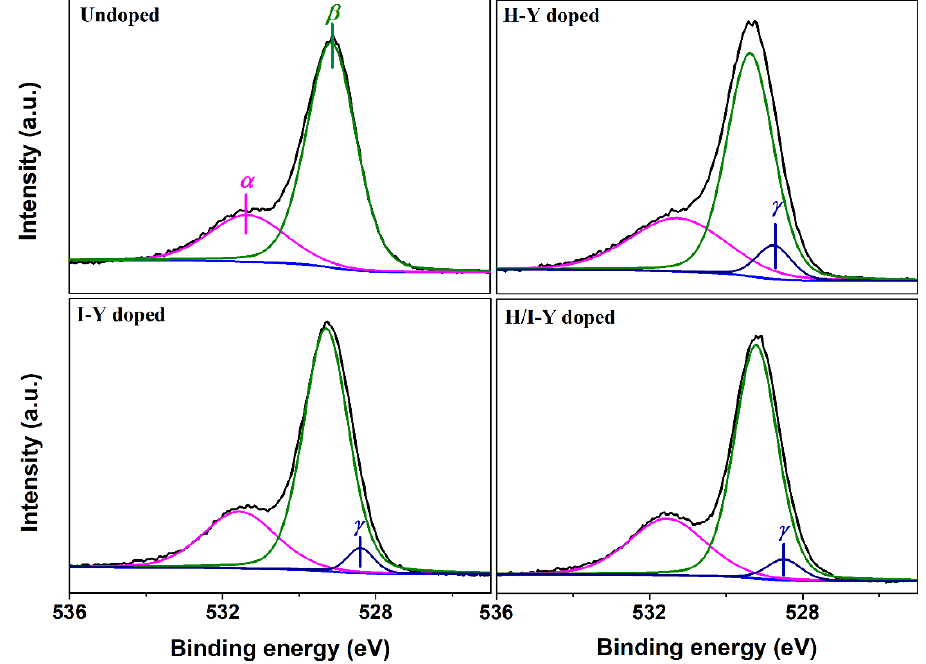
Figure 5. O 1s core-level XPS spectra of Undoped and H-Y-, I-Y-, and H/I-Y-doped CeO 2 .